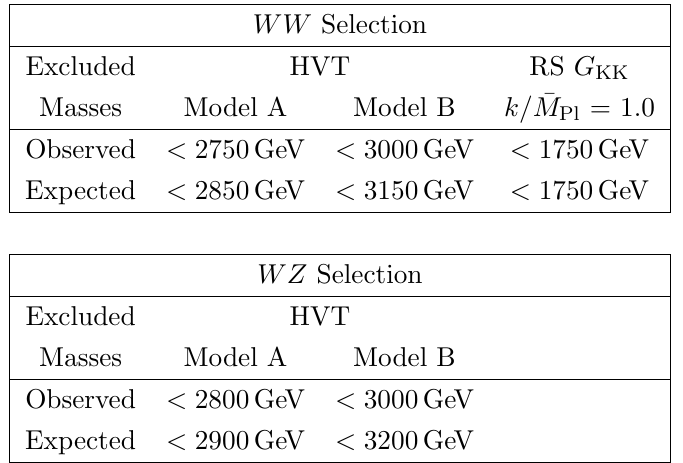
Table 5 . Observed and expected excluded masses at the 95% con(cid:12)dence level for various signal hypotheses as extracted from the ggF = q(cid:22)q category.